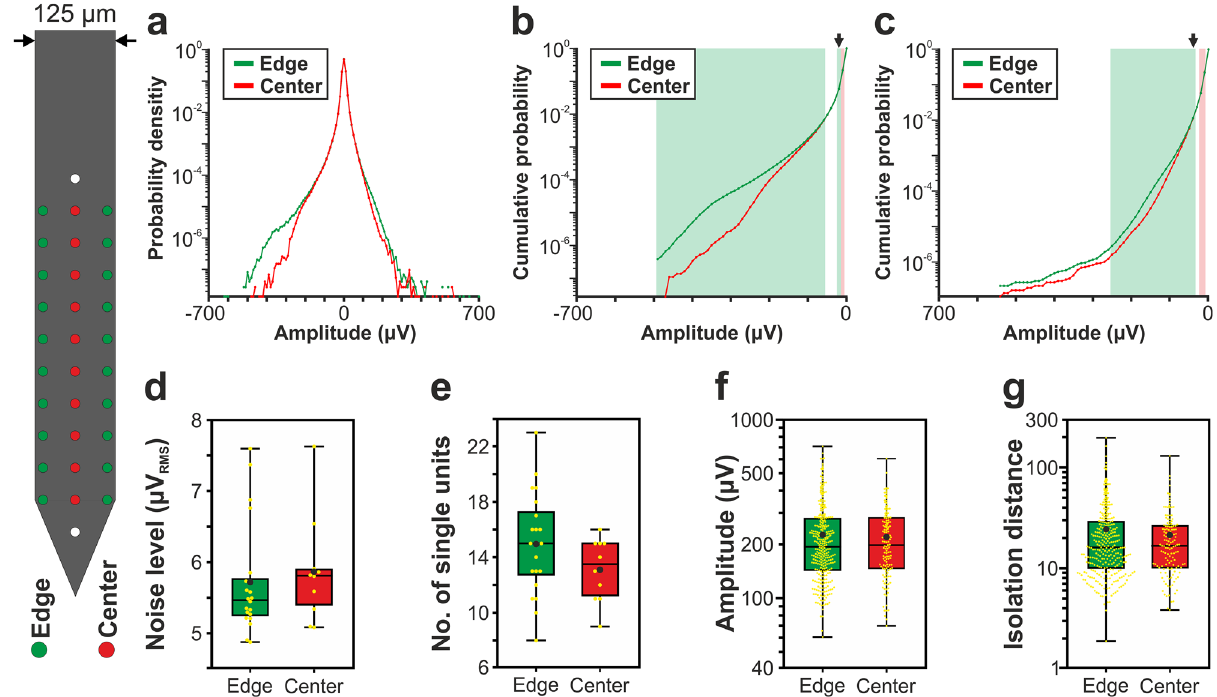
Figure 2. Comparison of the signal quality provided by edge (green) and center (red) sites of the 32-channel NeuroNexus silicon probe. ( a ) Probability density functions estimated from the amplitude of samples recorded in the 500–5000 Hz frequency range (n = 10 recordings). Probability values lower than 10 –9 are not shown. ( b ) Cumulative distributions of amplitudes calculated in the negative amplitude range. ( c ) Reverse cumulative distributions calculated in the positive amplitude range. Green (or red) shaded areas in ( b ) and ( c ) indicate amplitudes with significantly higher numbers of edge (or center) samples. Arrows mark the maximal amplitude for edge significance in the negative range (− 20 µV; below this amplitude 2.95% of all negative samples were recorded on edge sites and 2.93% on center sites) and the minimal amplitude in the positive range (40 µV; above this amplitude 0.59% of all positive samples were recorded on edge sites and 0.57% on center sites). ( d ) Estimated in vivo noise level. ( e ) Single unit yield (n = 430). ( f ) Peak-to-peak amplitude of the averaged single unit spike waveforms. ( g ) Isolation distance of the single unit clusters. In the boxplots, the middle line indicates the median, while the boxes correspond to the 25th and 75th percentile. Whiskers mark the minimum and maximum values. The average is depicted with a black dot, whereas individual values are indicated with smaller yellow dots. Note that most data are plotted on a logarithmic scale. Mann–Whitney U test was used in ( d – g